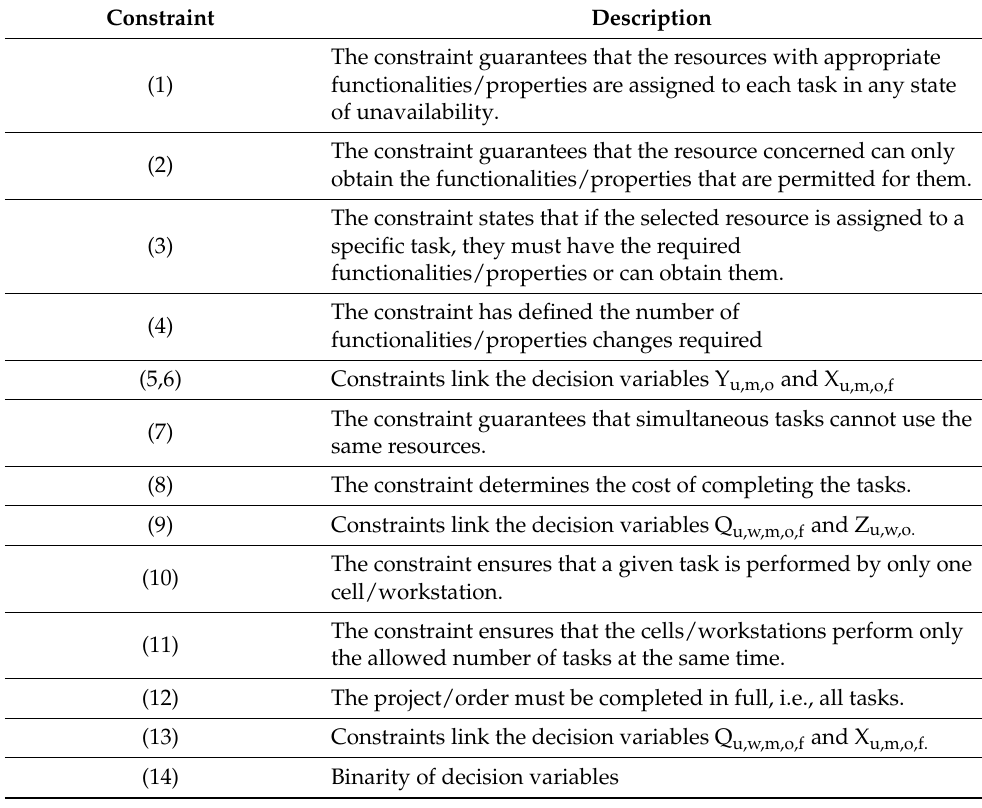
Table 3. Description of the constraints.